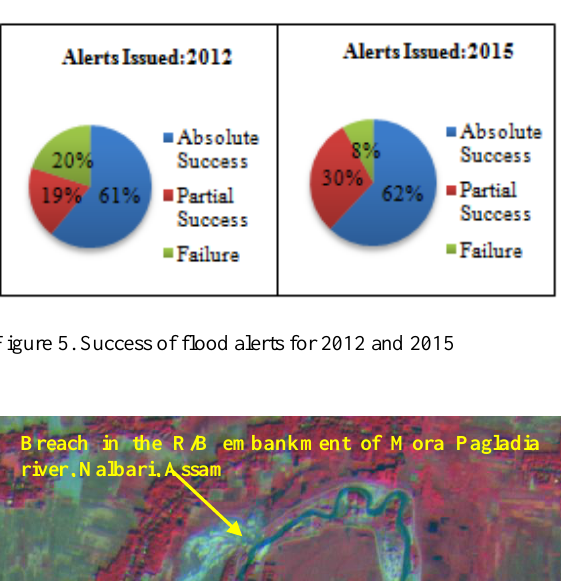
3.2.3 Forest fire alert dissemination/ vulnerability